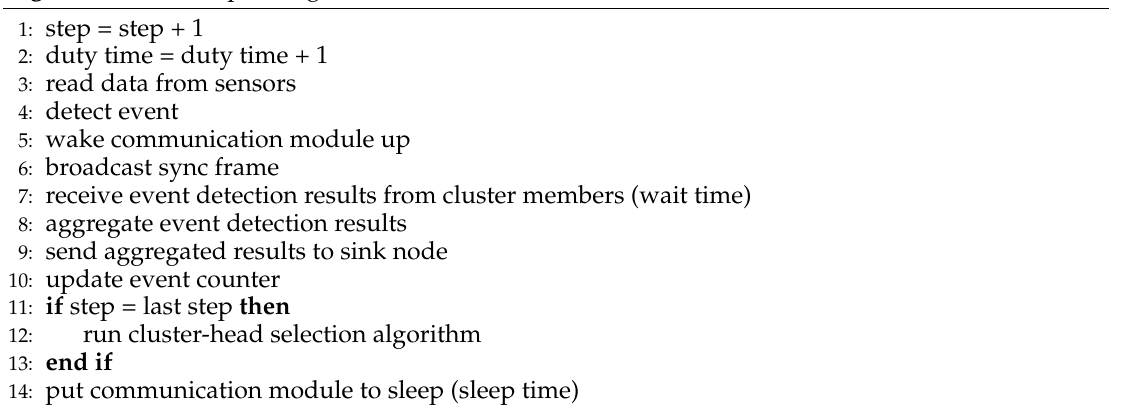
Algorithm 2 Node operating in cluster-head